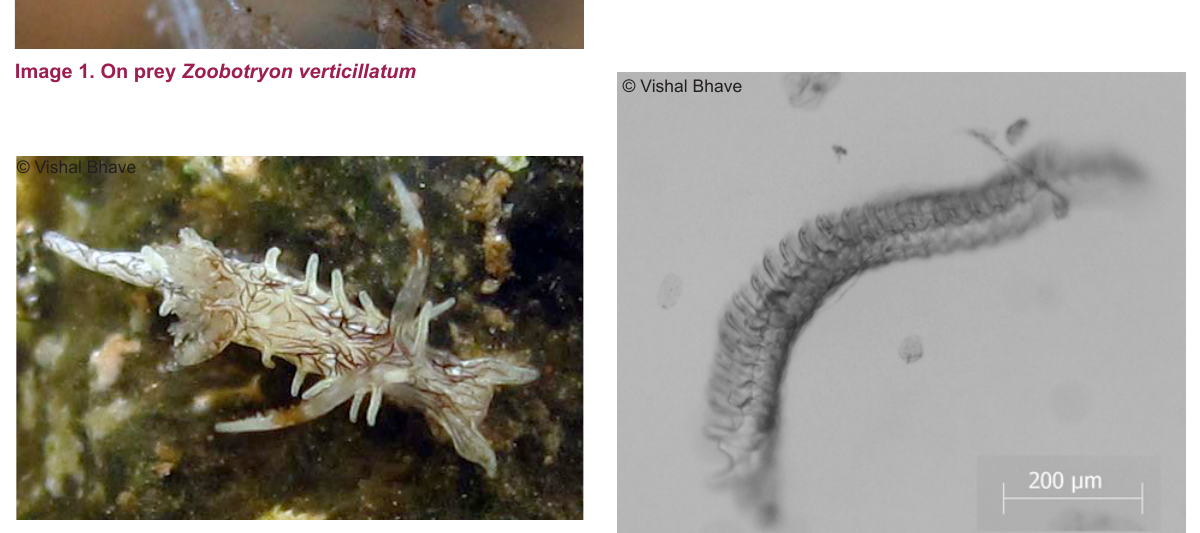
Image 3. Dorsal side